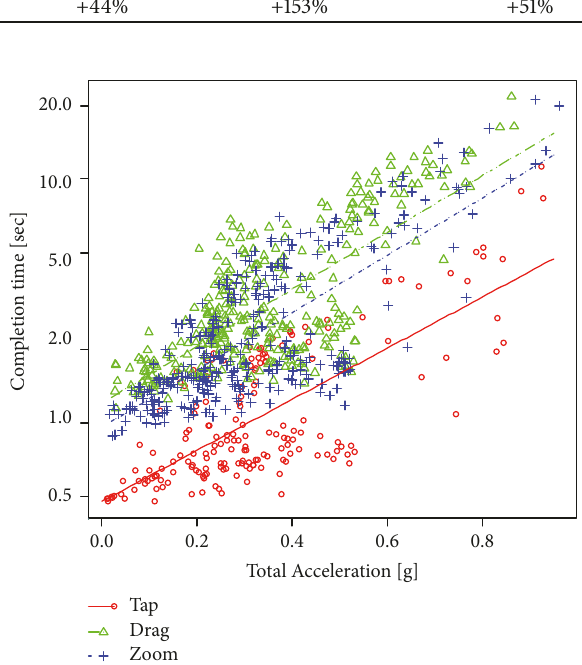
Figure 16: Evolution of the task completion time when acceleration increased and other parameters were kept at their mean value. Logarithmic